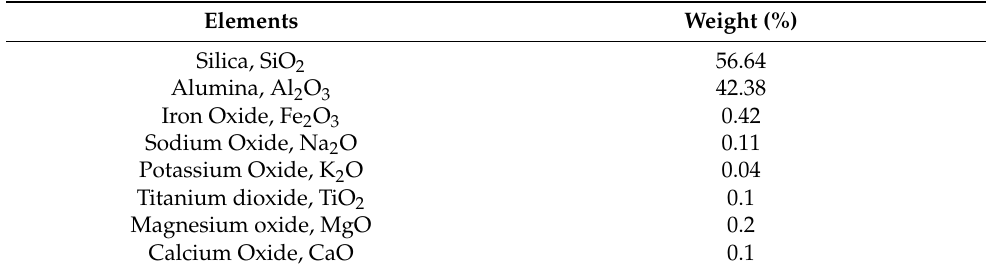
Table 3. Chemical composition of metakaolin.